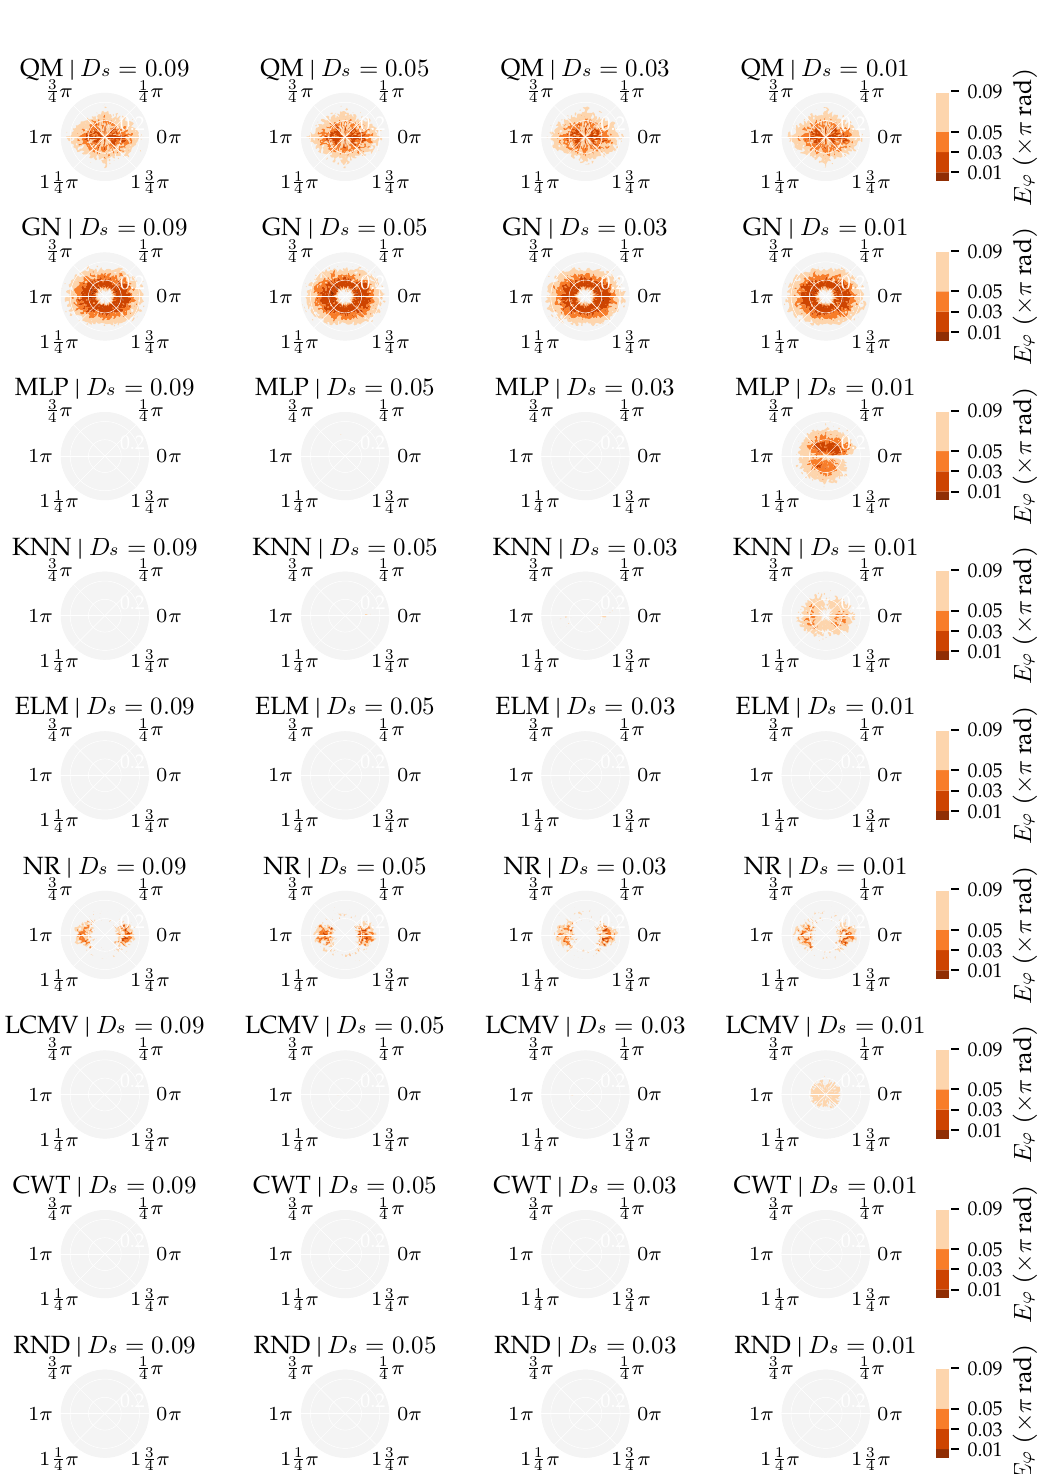
Figure A7. Polar contours of the median movement direction error (Equation (4)) for each localisation algorithm in all conditions of Analysis Method 1. These figures indicate how the movement direction ϕ and distance d of a source influence the error. This analysis varied the minimum distance D s between sources in the training and optimisation sets (Table 1) while using the (x + y) sensor configuration at the σ = 1 × 10 − 5 ms − 1 noise level. The median movement direction error was computed in 2 × 2 cm 2 cells. The sensors were equidistantly placed between x = ± 0.2